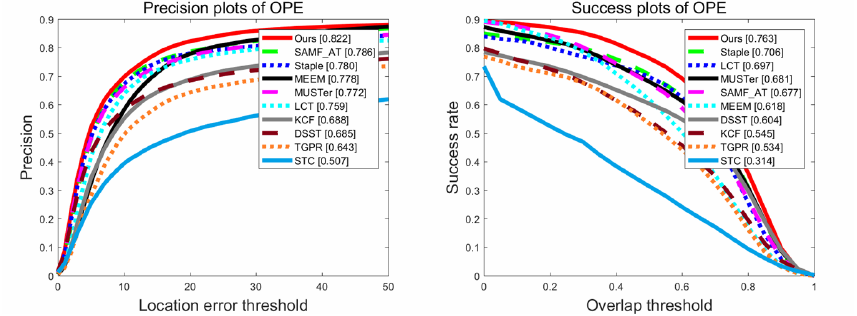
Figure 3. Precision and success plots of different trackers on the OTB-2015 dataset. Our tracker is better than other